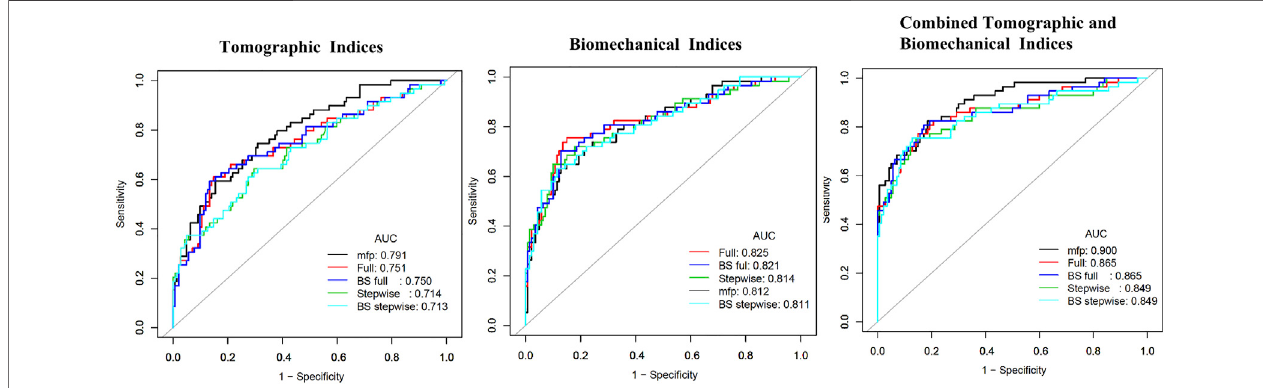
FIGURE 1 | Receiving operating characteristic curve and area under the curve (AUC) in tomographic indices, biomechanical indices, and combined tomographic and biomechanical indices.